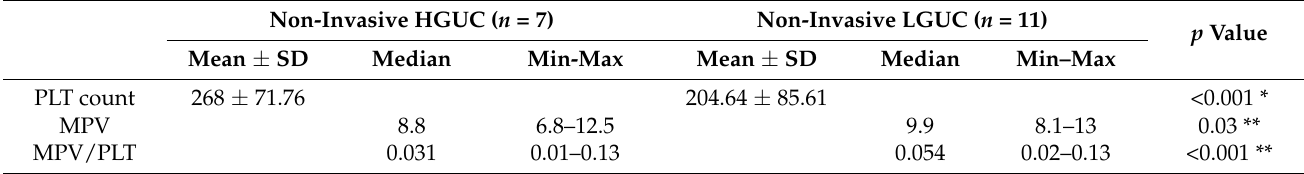
Table 6. Comparison of mean platelet count, MPV and MPV/PLT among non-invasive HGUC and non-invasive LGUC. Non-Invasive HGUC ( n =